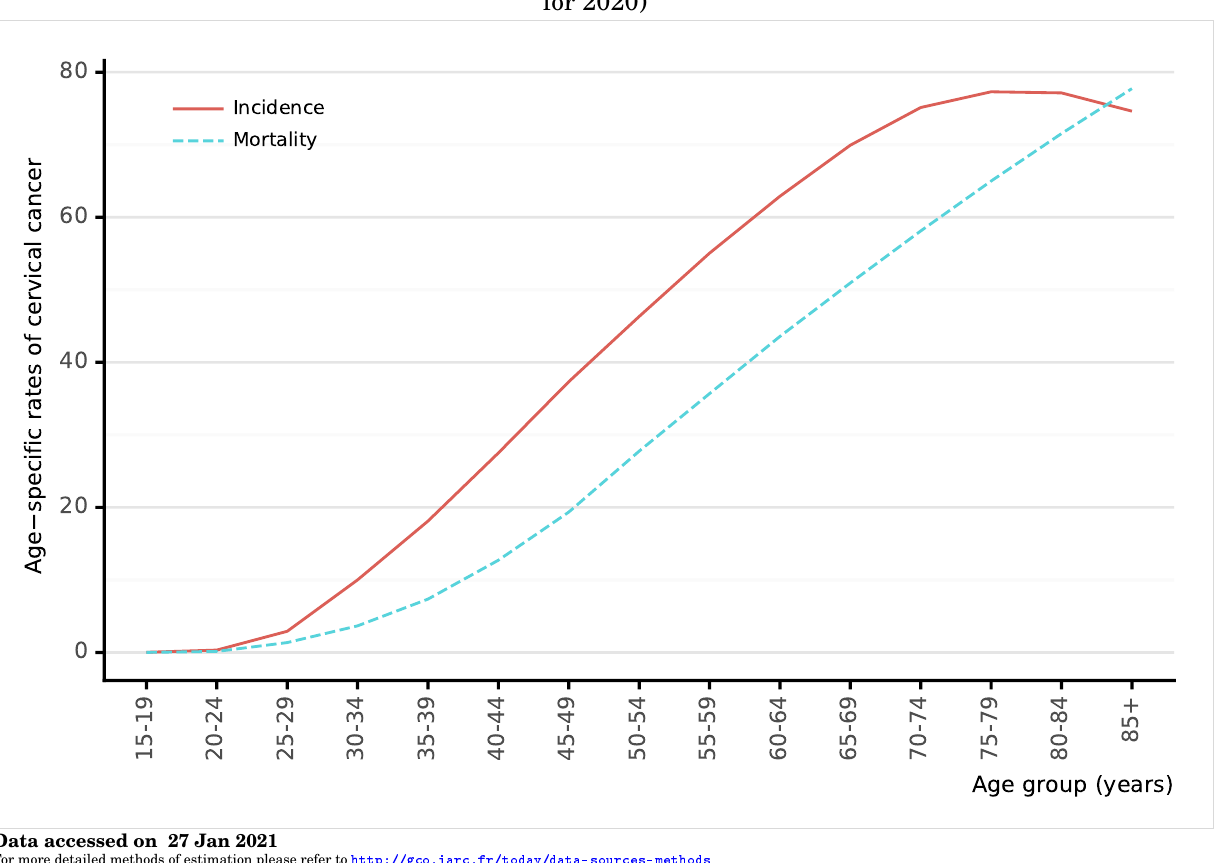
Figure 13: Comparison of age-specific cervical cancer incidence and mortality rates in India (estimates